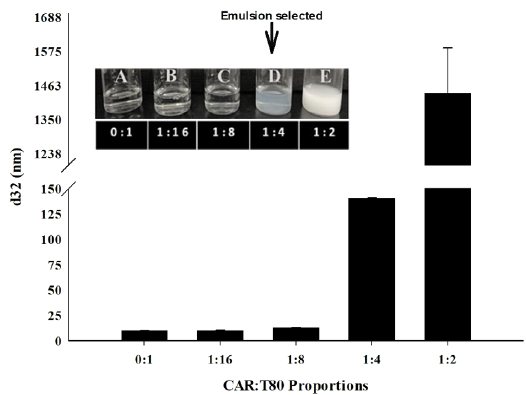
Figure 1. Diameter droplets of the micelles of CAR:T80 emulsions after preparation. The image show the visual appearance of the emulsions where; ( A ) Control, ( B ) 1:16, ( C ) 1:8, ( D ) 1:4 and ( E ) 1:2 of CAR:T80